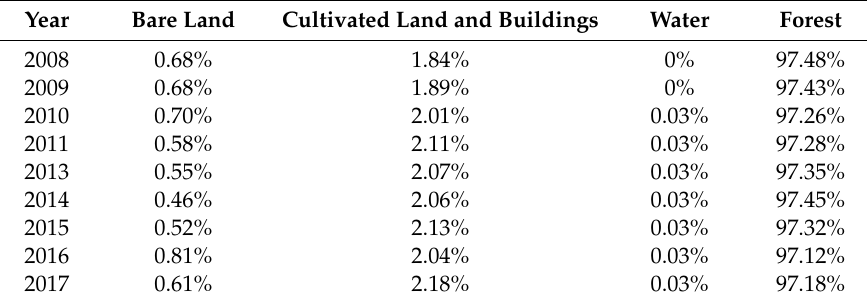
Table 2. Landsat land-use classification results